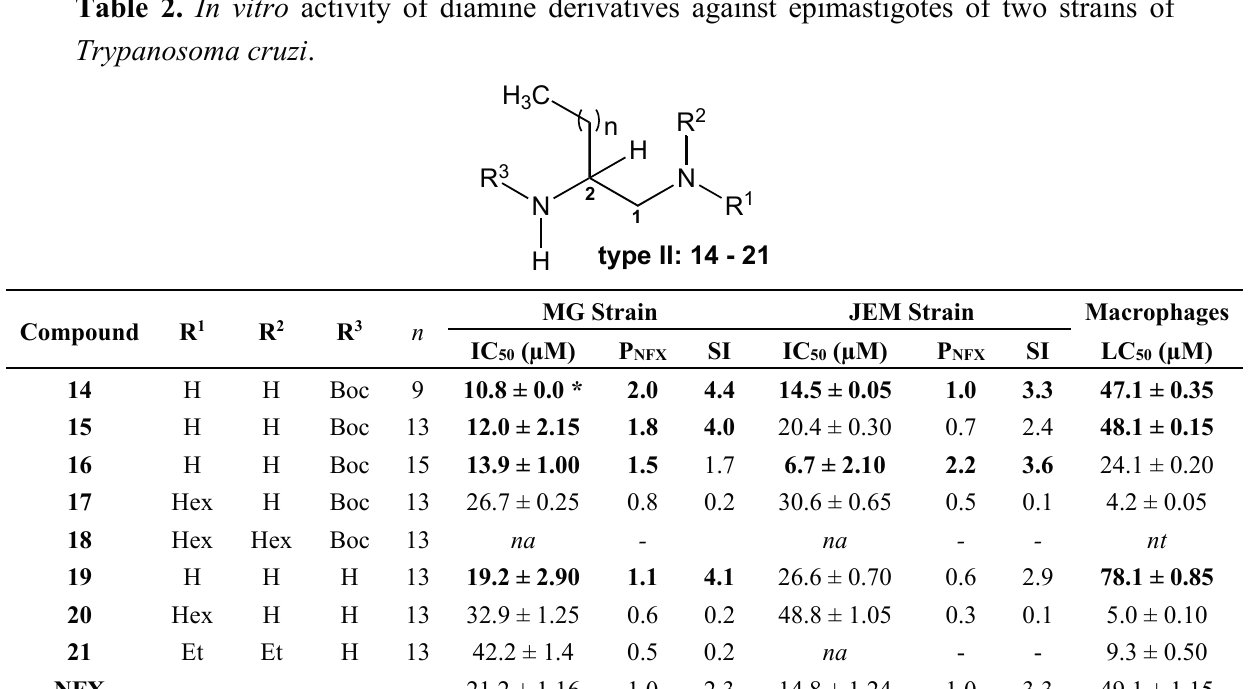
Table 2. In vitro activity of diamine derivatives against epimastigotes of two strains of Trypanosoma cruzi .